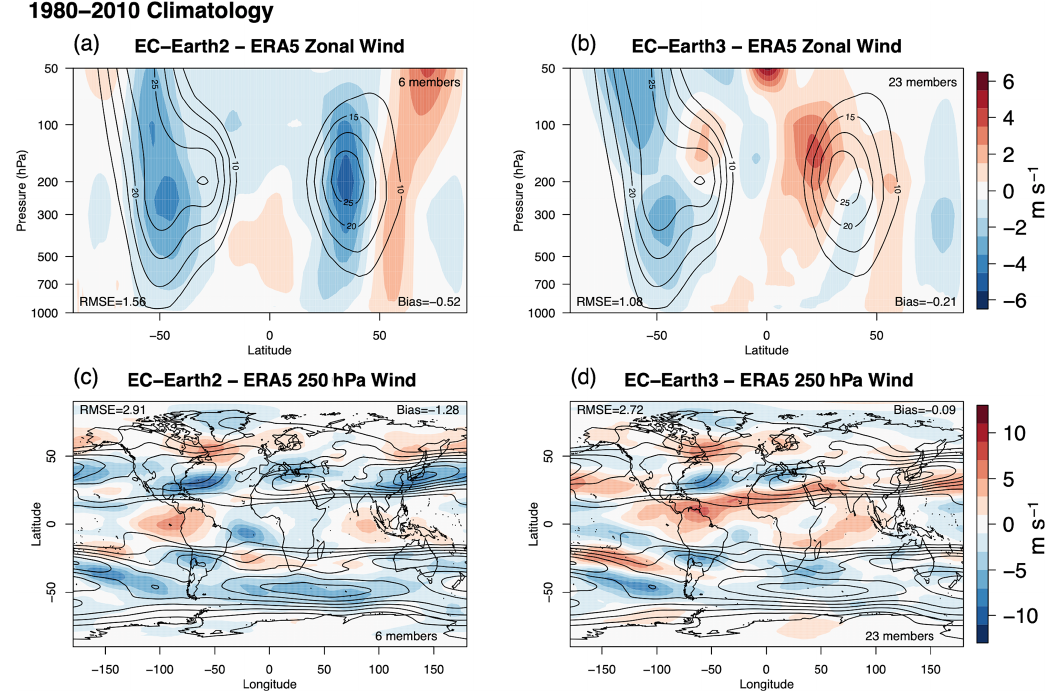
Figure 8. (a, b) Biases (colored shading) of the zonally averaged zonal component of wind for EC-Earth2.3 (a) and EC-Earth3 against ERA5 reanalysis over the 1980–2010 period. Contours show the ERA5 climatology. (c, d) Biases (colored shading) of the 250hPa zonal component of wind for EC-Earth2.3 (a) and EC-Earth3 against ERA5 reanalysis over the 1980–2010 period. Contours show the ERA5 climatology. Root mean square error, mean bias, and the number of ensemble members used are reported in each